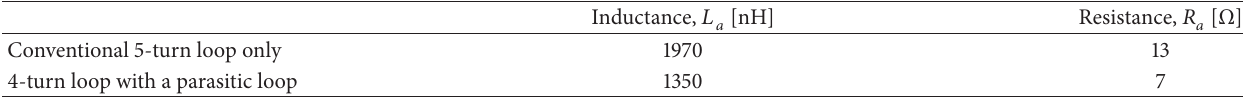
Table 1: Measured inductance and resistance of the proposed antenna.